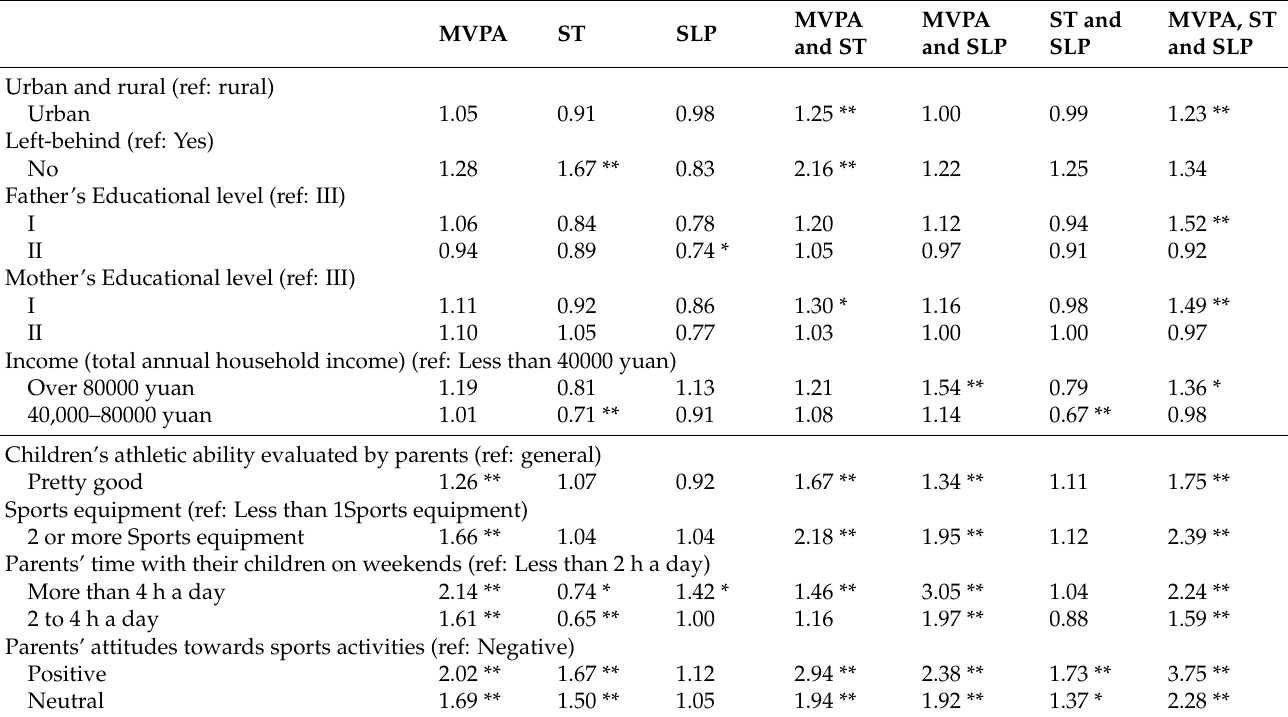
Table A3. The OR values for the 8 combinations of three health-related behaviors. (controlling the children’s sex, age and body mass